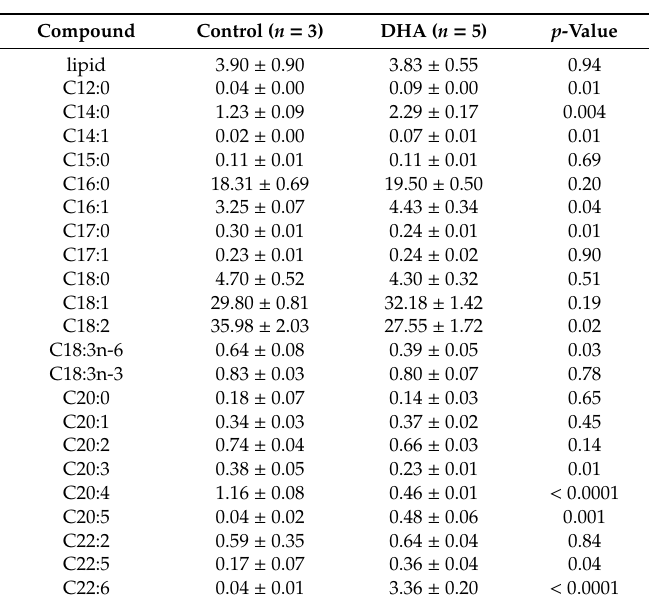
Table 2. Colostrum fatty acid composition from sows fed with / without DHA during late gestation and